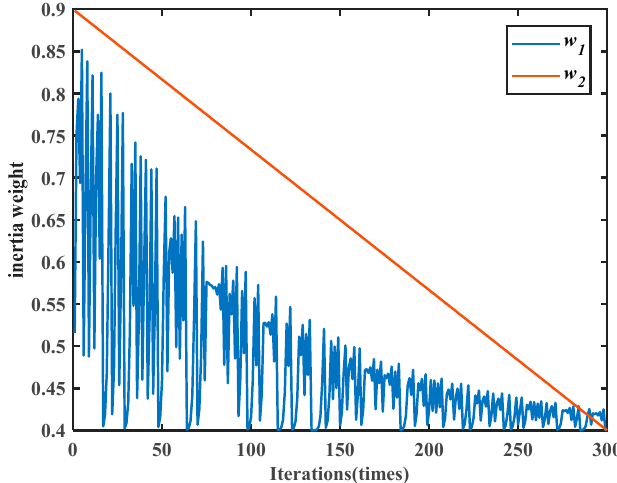
Figure 1. Descending trend of different inertia weights when Two test functions (i.e., Griewank and Ackley function) with the same independent